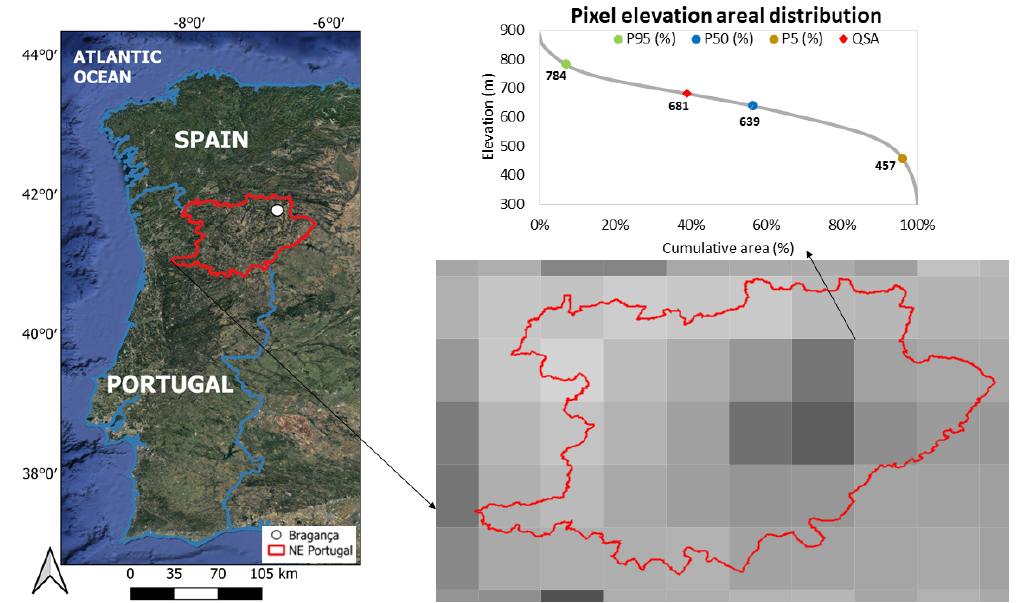
Figure 1. Location of the study area: Bragança in NE Portugal, Quinta de Santa Apolónia weather station (QSA, ground data source) and ESA SM pixel (satellite–borne data source) with the elevation areal distribution (P95, P50 and P5 are percentiles).